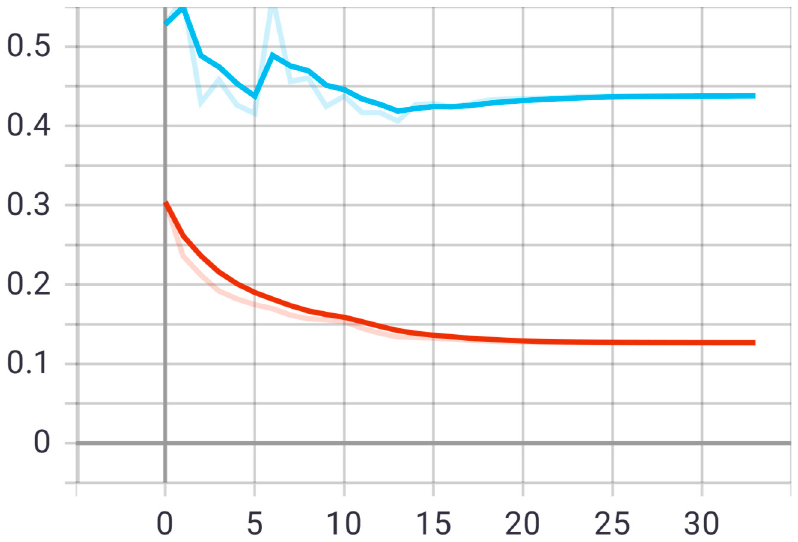
Figure 13. Accuracy (red line) and validation (blue line) loss curves of the first model over 30 epochs. The overall performance based on the metrics is shown in Table 3. Table 3. The overall performance of the first model on 3D-IRCADb-01 dataset.